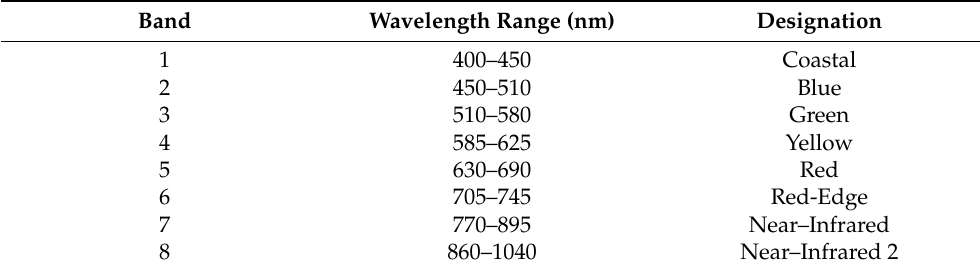
Table 1. Detailed spectral range of the 8-band Worldview-3